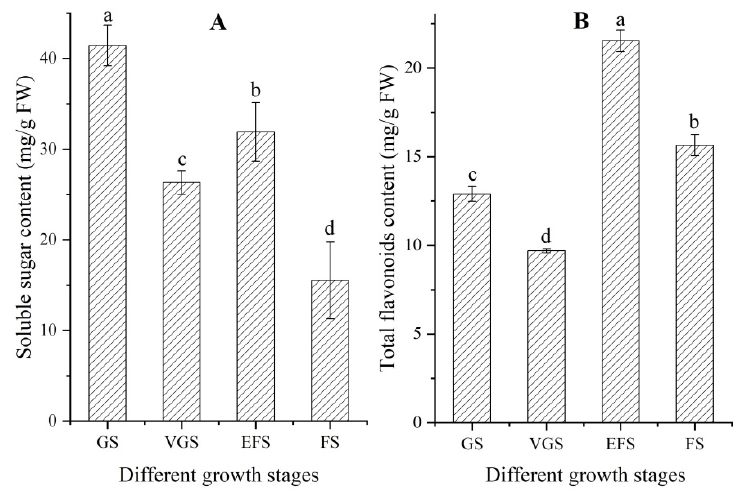
Figure 2. Soluble sugar and total flavonoids contents in stems of C. songaricum at four different growth stages (mean ± SD, n = 3). Images ( A , B ) represent soluble sugar and total flavonoids contents, respectively. Different letters represent a significant difference ( p < 0.05) at different growth stages.